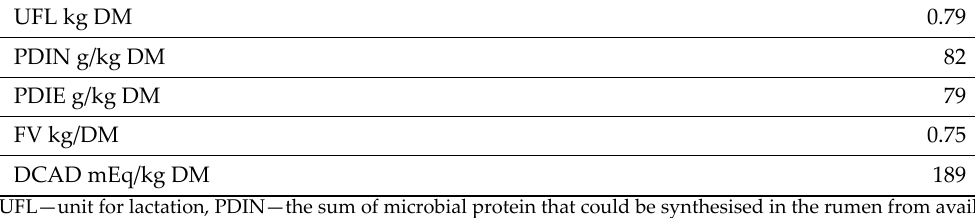
Table 1. Diet nutritional value of cows (g/kg